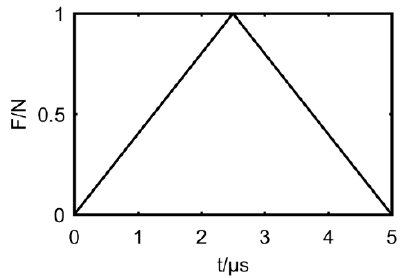
Figure 2. The time profile of transient triangular force.